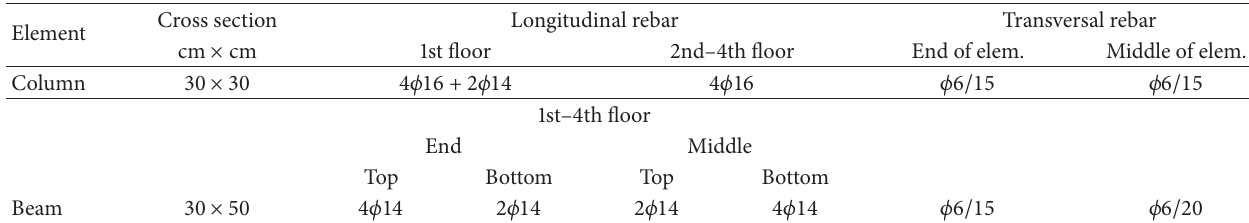
Figure 2: Benchmark structure: (a) plan view and (b) numerical model; (c) elastic response spectra. Table 1: Details of cross section of the main structural